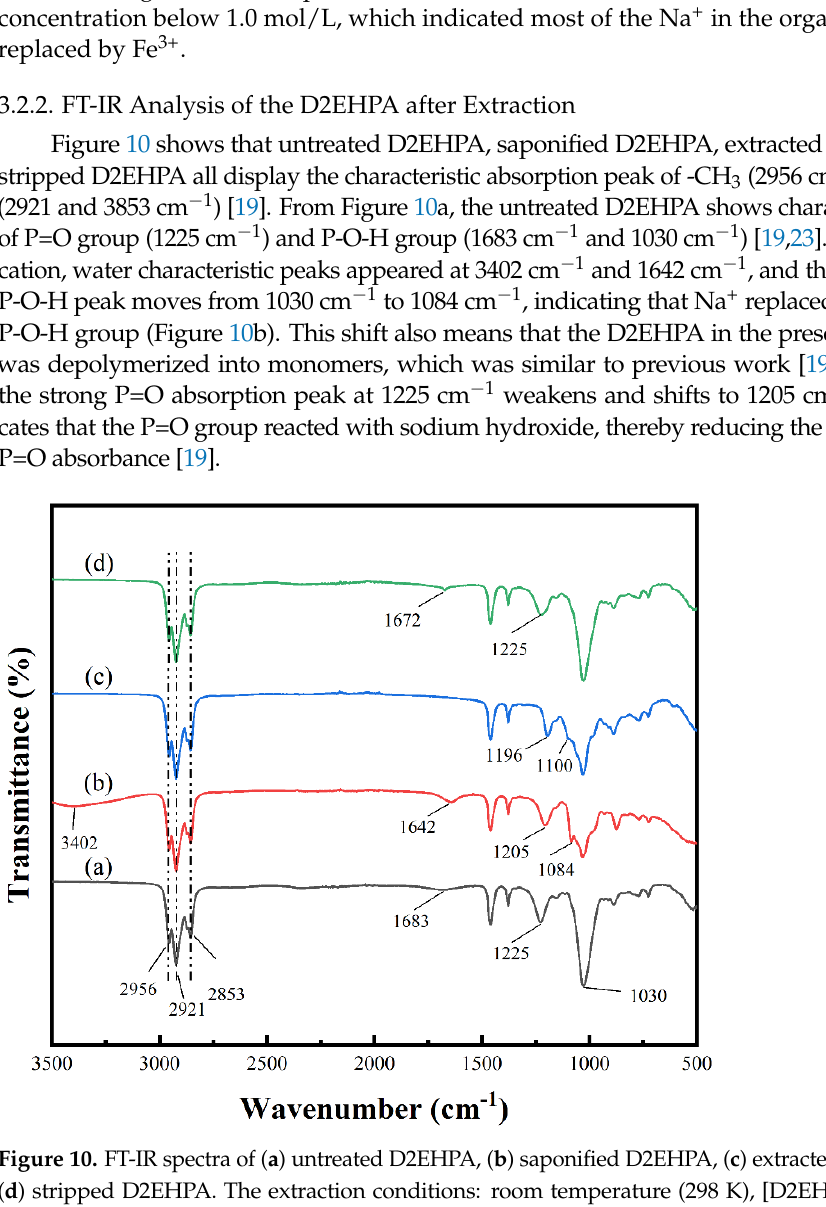
Figure 9. ( a ) Slope analysis of the extraction under various D2EHPA concentration, ( b ) Na + replace- ment after extraction under various D2EHPA concentration.